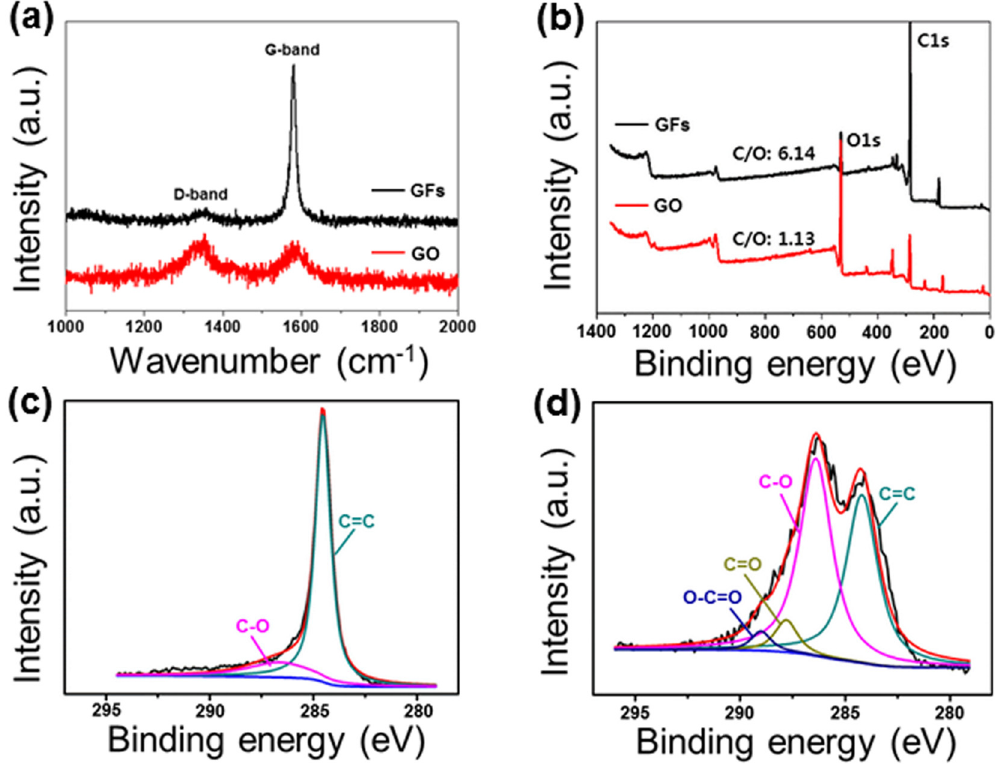
Figure 4: Characterization of GO: ( a ) Raman spectra of the GF and GO, ( b ) XPS survey spectra of the GF and GO, ( c ) C 1s spectra of the GF, and ( d ) C 1s spectra of the